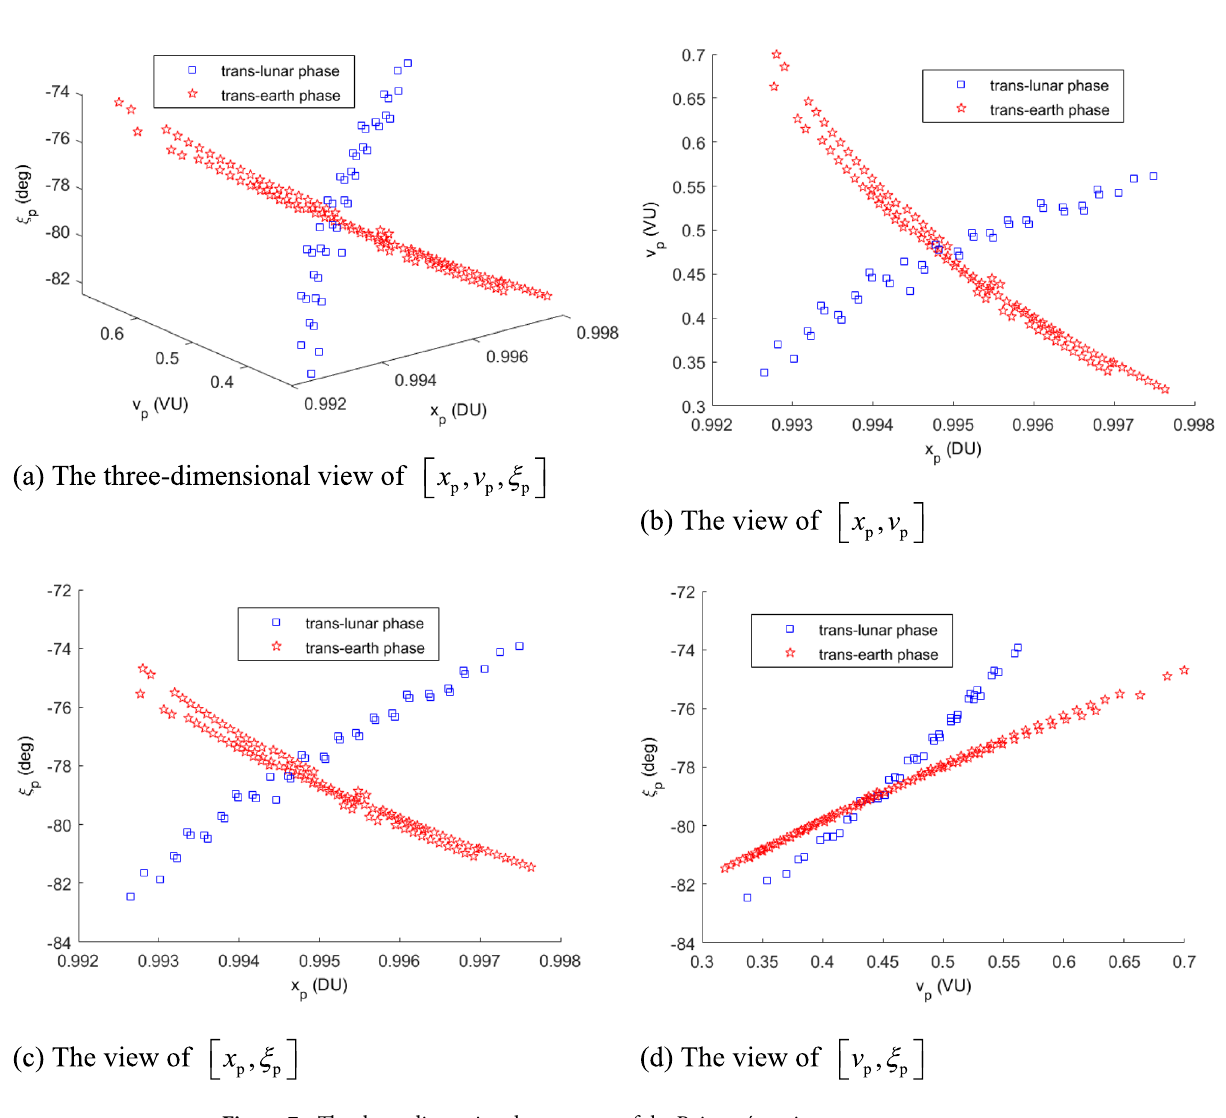
Figure 7. The three-dimensional parameter of the Poincaré